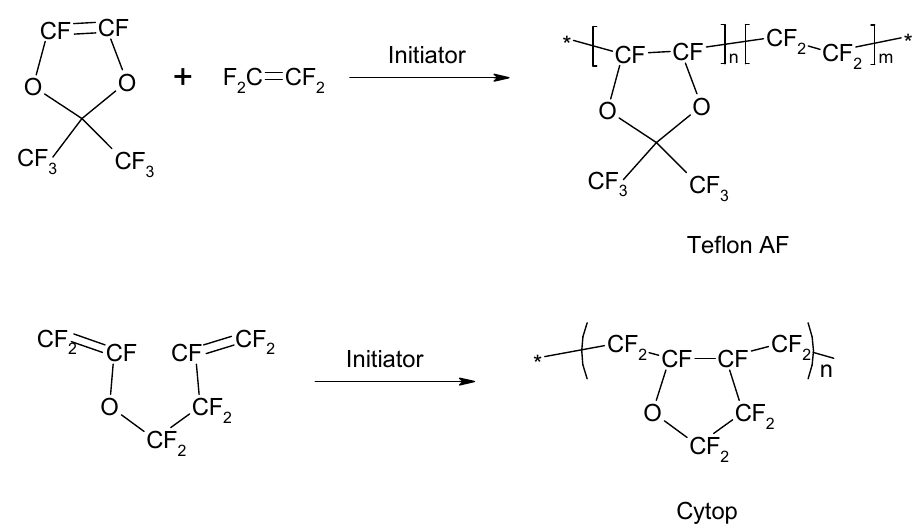
Figure 10. The preparation of Teflon AF and